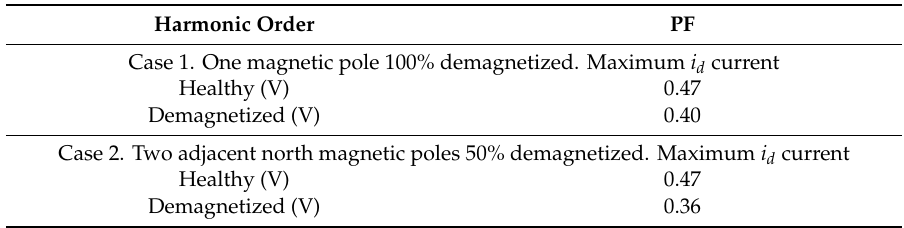
Table 5. Power factor underrated speed and applying the maximum i d current ( i q = 0). Healthy and partially demagnetized fPMa-SynRMs.